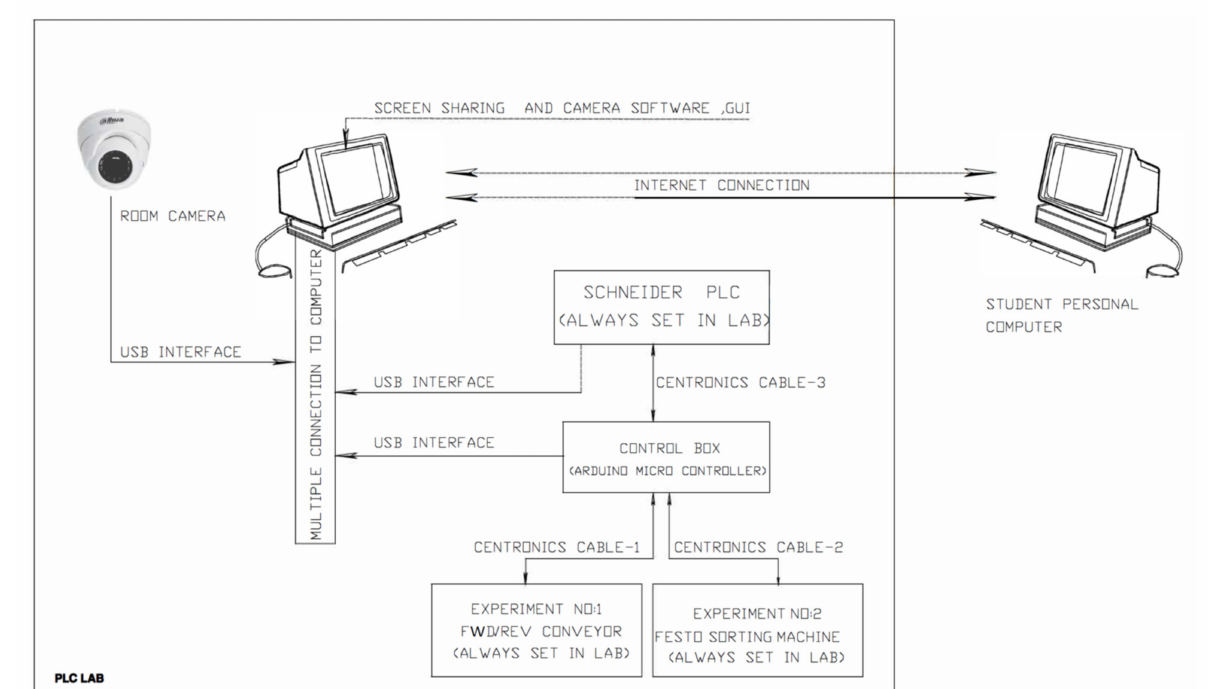
Figure 1. Block diagram of the remote laboratory system.